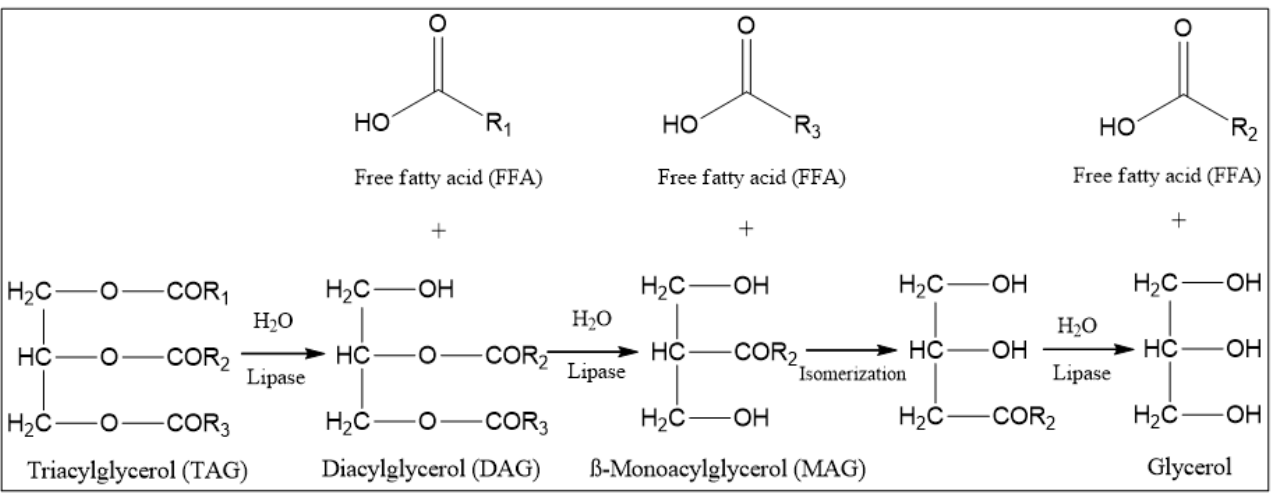
Figure 1. Hydrolysis of triacylglycerols catalyzed by lipase.